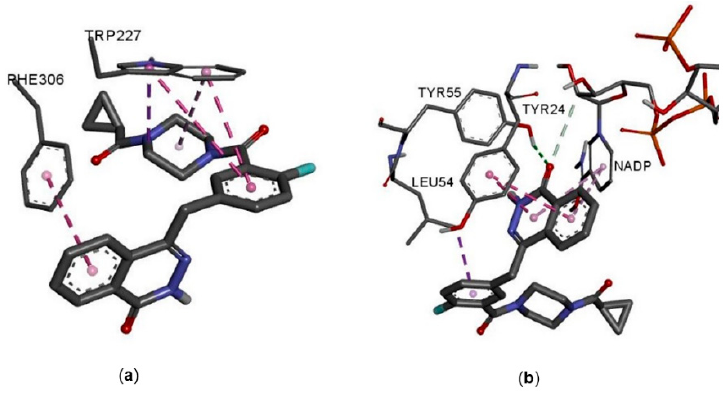
Figure 4. Interactions of olaparib with the AKR1C3 flexible residues. ( a ) Rigid residues and NADP. ( b ) Amino acid residues involved in interactions with a ligand are rendered as sticks. Ligands are rendered as double-sized sticks. Carbon is illustrated in grey, nitrogen in blue, oxygen in red, fluorine in cyan, phosphorus in orange, and hydrogen in white. Only polar hydrogens are shown. H-bonds are depicted as green dashed lines, and hydrophobic interactions as violet dashed line ( π – σ in dark violet, π – π in pink, and π –alkyl in light pink).